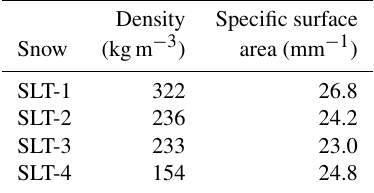
Table 1. Initial values of density and specific surface area for the four sintered low-temperature snow samples used in Wang and Baker (2013). Naming convention follows Fierz et al.